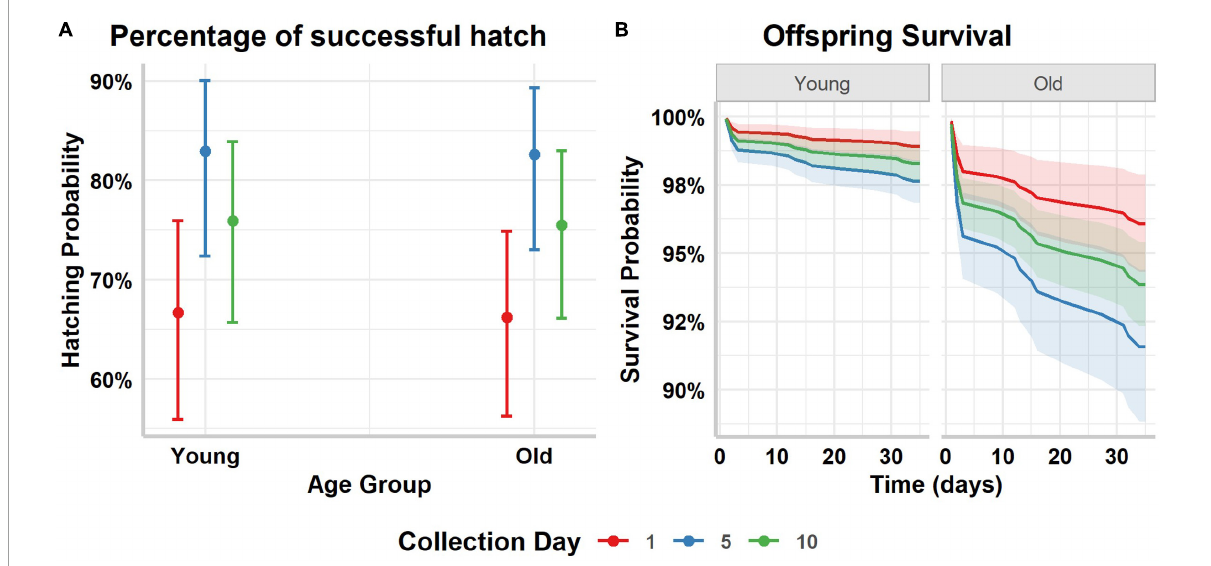
FIGURE3 Predicted marginal means of the (A) hatching success and the corresponding 95% confidence intervals, (B) and chick survival during the first month of life and the corresponding standard errors, per male and sperm age. Collection day refers to the day sperm was collected after a common initial collection, and it is used as a proxy of sperm